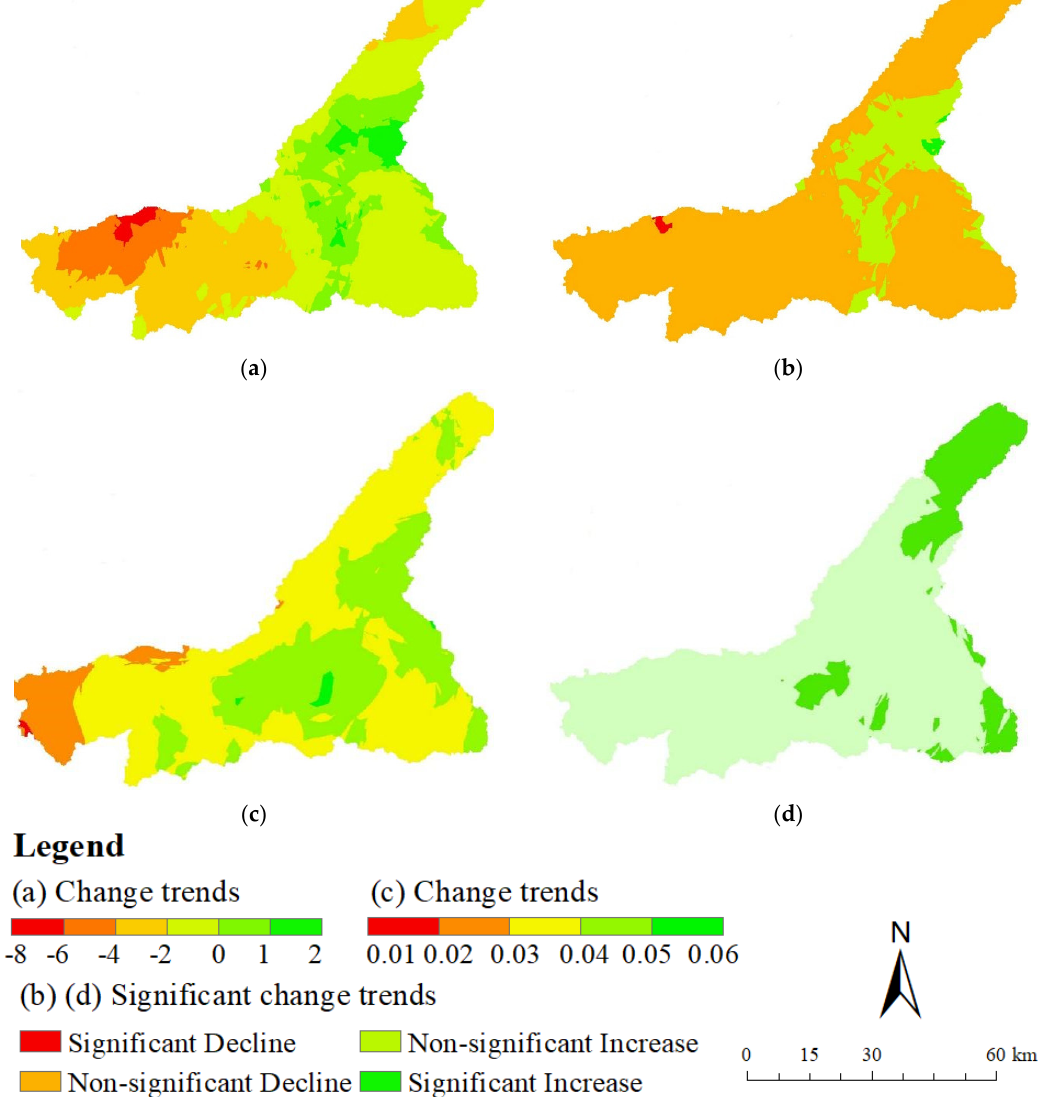
Figure 7. Spatial distribution of temperature and precipitation change trends in dry seasons in Mara River Basin: ( a ) Precipitation change trend in dry seasons ( S -value); ( b ) precipitation significant change trend in dry seasons ( Z -value); ( c ) temperature change trend in dry seasons ( S -value); ( d ) temperature significant change trend in dry seasons ( Z -value). Figure 8 showed the density scatter plots of RF regression for VG and VGT, the R 2 values were 0.95 and 0.91, respectively; the RMSE values were both 0.023. The fitting de- gree of the models were high, which verified the feasibility of the RF algorithm in analyz- ing the responses of VG and VGT to temperature and precipitation in the Mara River Ba- sin.